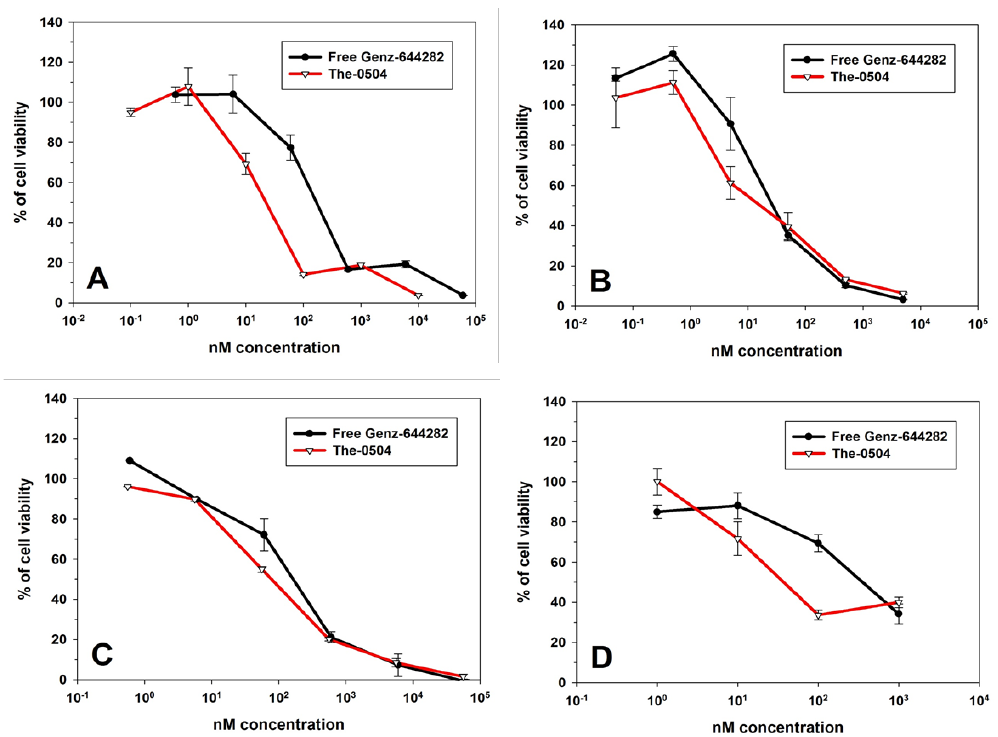
Figure 4. In vitro cytotoxicity. XTT assays performed on four cancer cell lines. ( A ) HT-29 colorectal cancer cells ( B ) MiaPaCa 2 pancreatic cancer cells; ( C ) PaCa44 pancreatic cancer cells and ( D ) HPAF II pancreatic cancer cells.